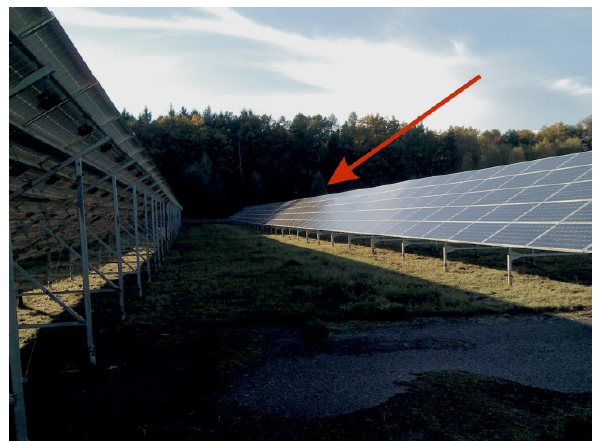
Figure 12. Trees overshadowing the section of the PV plant [25].